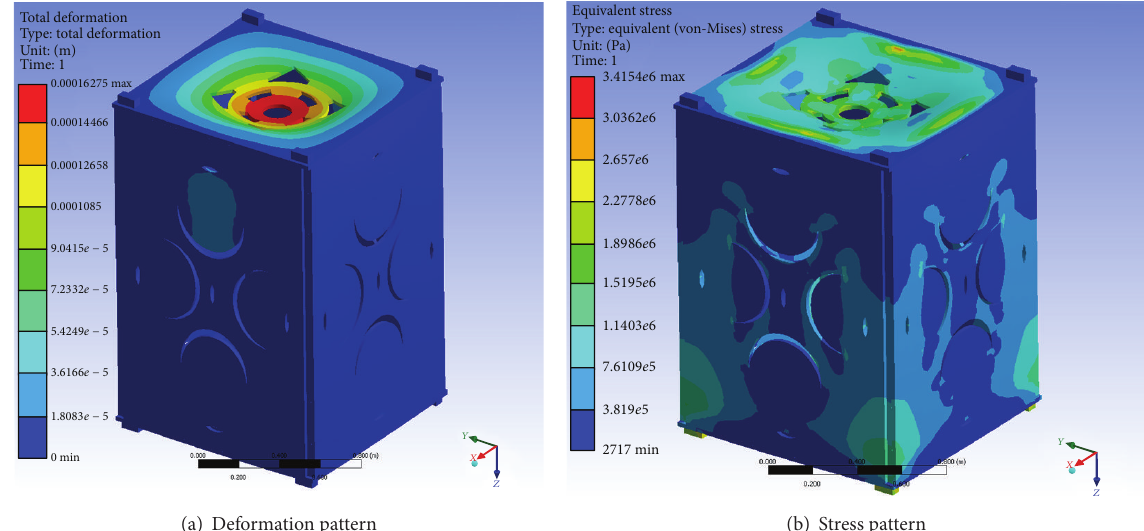
Figure 2: Deformation and stress pattern.